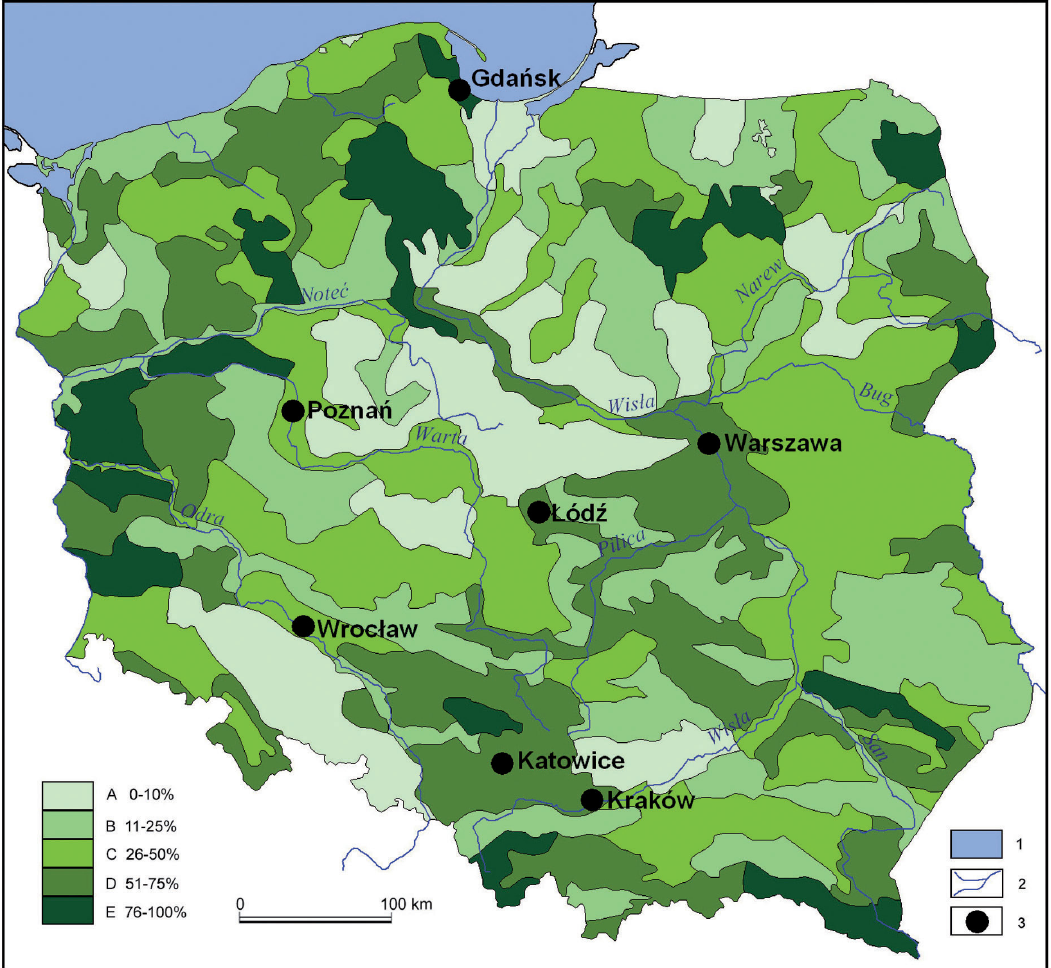
Fig. 1. The current degree of landscape opening/enclosure in